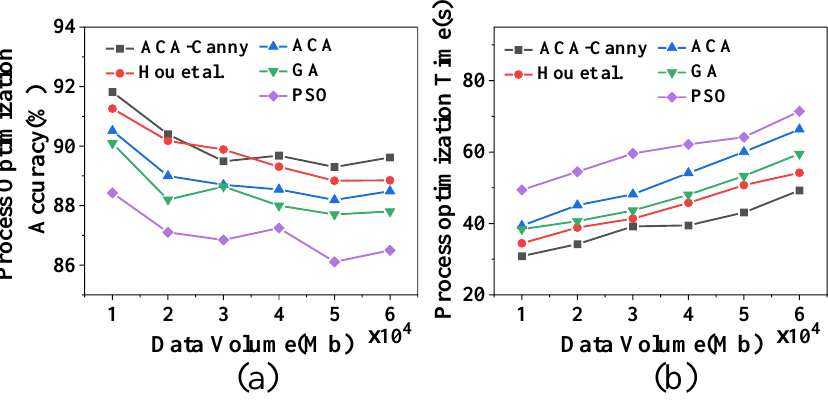
Figure 9. Curves of process optimization accuracy and required time of plant factory under different data amounts ( a ) process optimization accuracy; ( b ) required time.